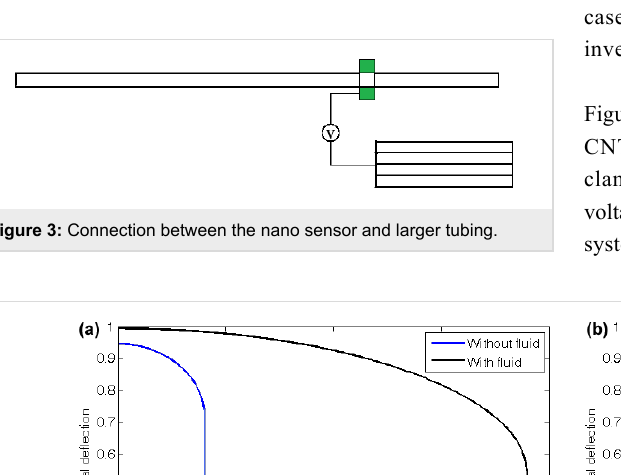
the corresponding voltage is the pull-in voltage. If the behavior is static, the pull-in will be static. In the case of dynamic motion, the pull-in will be a dynamic pull-in. Details are to be discussed in the following sections.